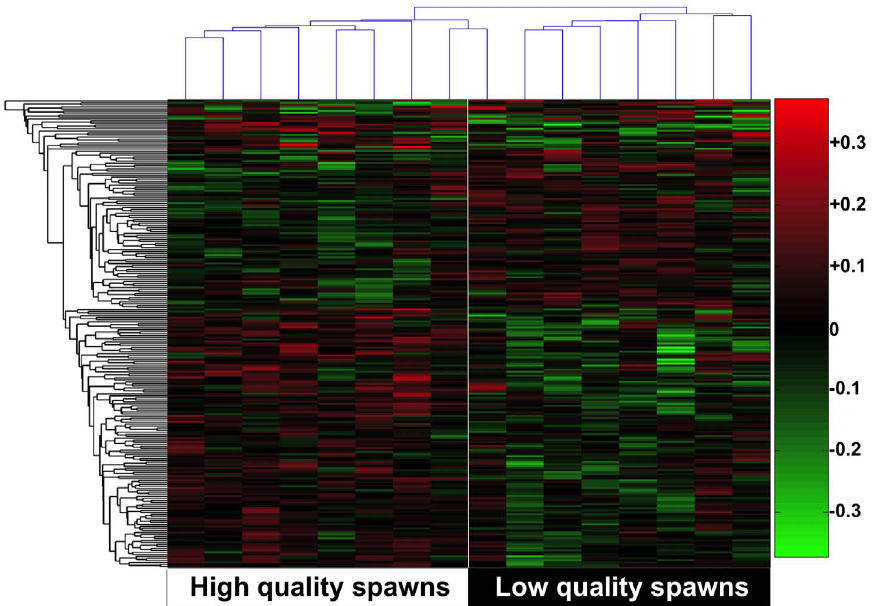
Figure 2. Two-dimensional hierarchical clustering heat map of the microarray data showing transcript expression profiles for genes (n=233) expressed in ovary biopsies of female striped bass that produced low and high quality spawns. Levels of gene expression are indicated on the color scale to the right with numbers indicating the fold difference from the grand mean for all fish (shown in black and indicated by the zero value), red indicating increased transcript expression, and green indicating decreased transcript expression. Fish producing high or low quality spawns are grouped as indicated at the bottom of the figure. The clustering of individual genes with respect to their similarity in changes of expression between individual fish is represented by the dendrogram to the left. The dendrogram at the top shows similarities in gene expression patterns between individual fish regardless of group.